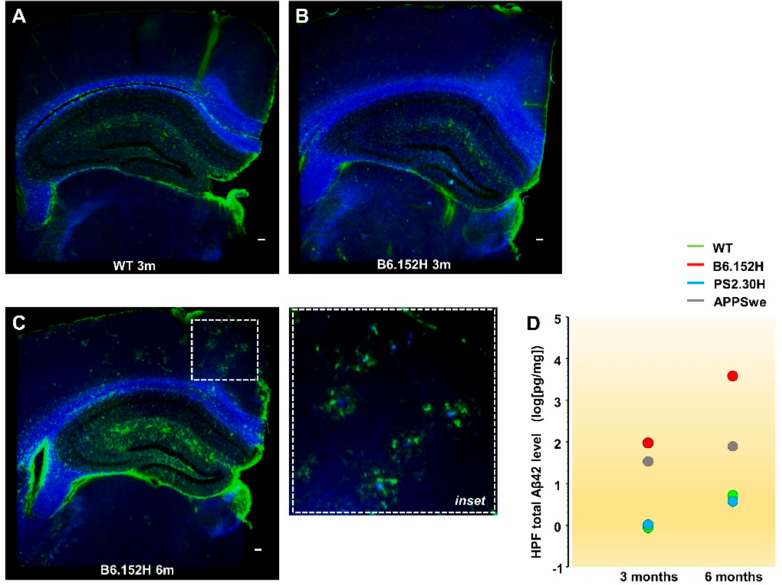
Figure 1. Amyloidosis and gliosis in B6.152H mice. Representative images of coronal sections (50 µ m) from the left hemibrains of WT ( A ) and B6.152H ( B , C ) mice. At the hippocampal and cortical levels, six- ( C ) but not three- ( B ) month-old B6.152H mice show plaques, stained with methoxy-X04 (blue) surrounded by activated astrocytes, stained by GFAP antibody (green); see also the inset (scale bar = 0.1 mm). ( D ) Total A β 42 accumulation, estimated with a human / rat A β 42 ELISA in the HPF of three- (WT: 0.6 ± 0.5; PS2.30H: 0.7 ± 0.3; APPSwe: 16 ± 1.6; B6.152H: 110 ± 52 pg / mg wet tissue) and six-month-old mice (WT: 2.3 ± 0.2; PS2.30H: 3.5 ± 2.4; APPSwe: 92 ± 46; B6.152H: 4450 ± 70 pg / mg